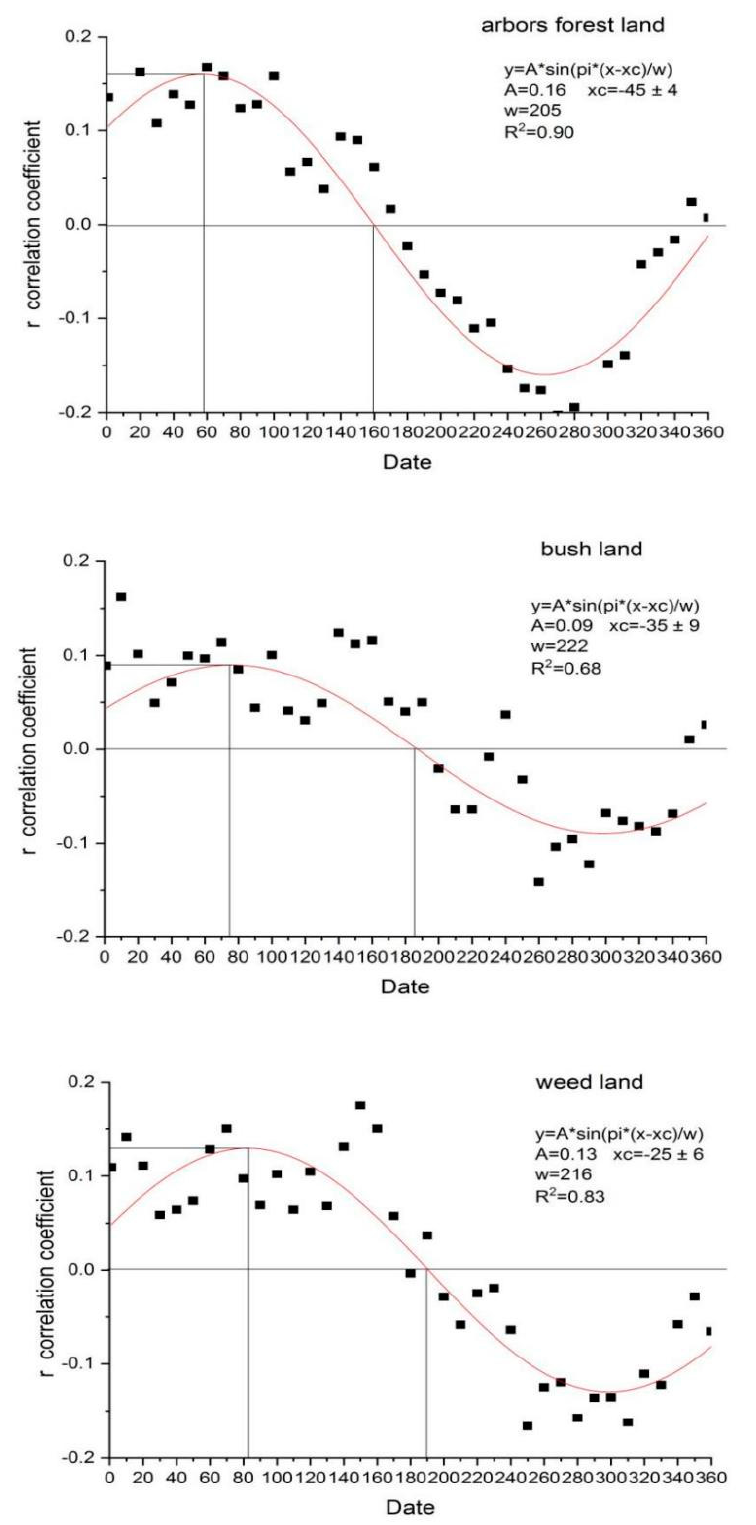
Figure 9. Date model diagram of Pearson’s coefficient r for daily precipitation and soil moisture content of three site types.